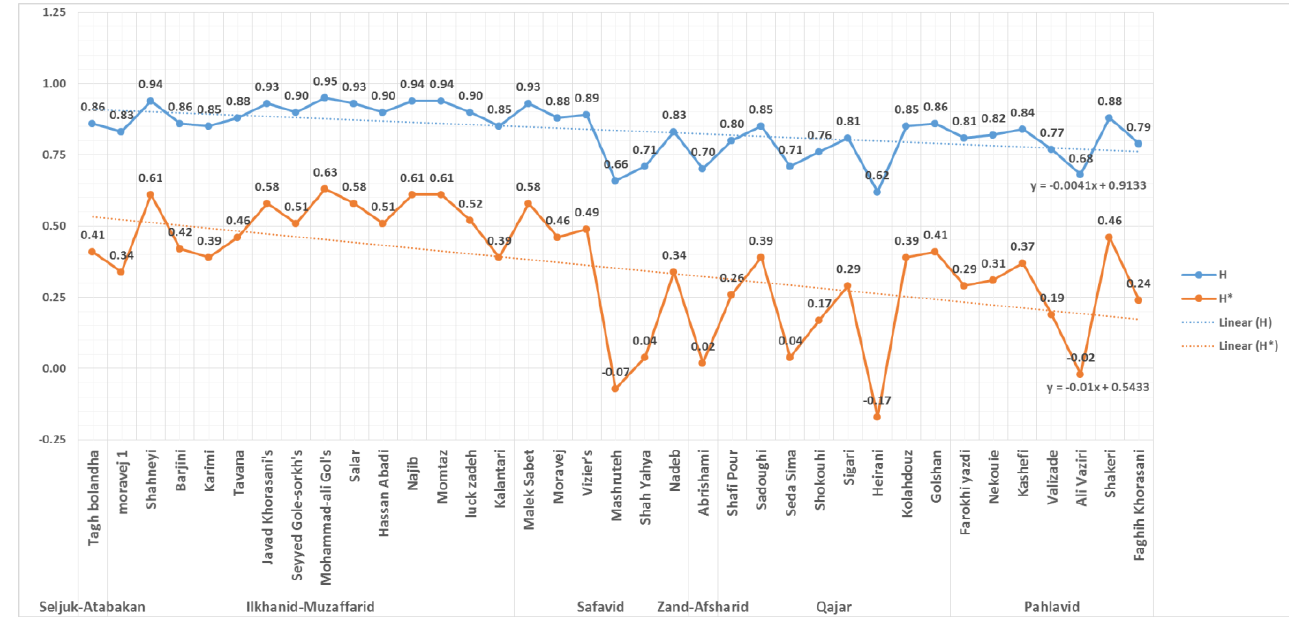
Figure 12. H and H* results and trendlines for the 37 houses, presented chronologically by era.